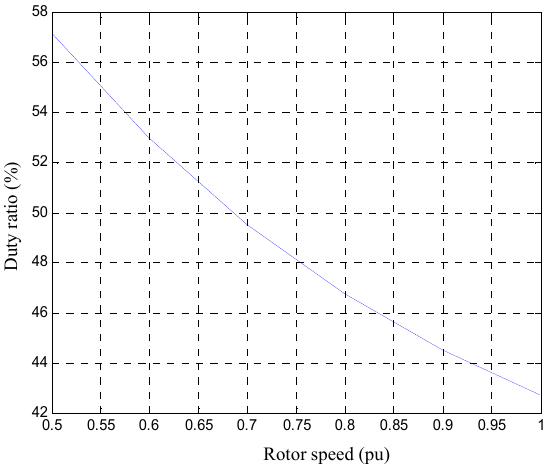
Figure 6. Duty ratio versus rotor speed.